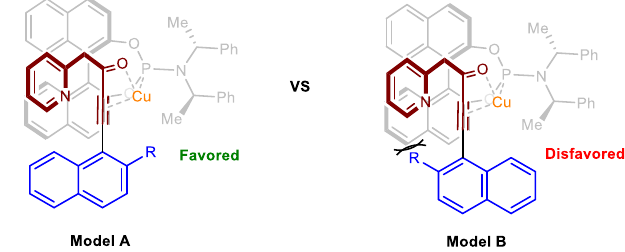
Fig. 8 Proposed stereoinduction modes. Cl − is omitted for simplicity.